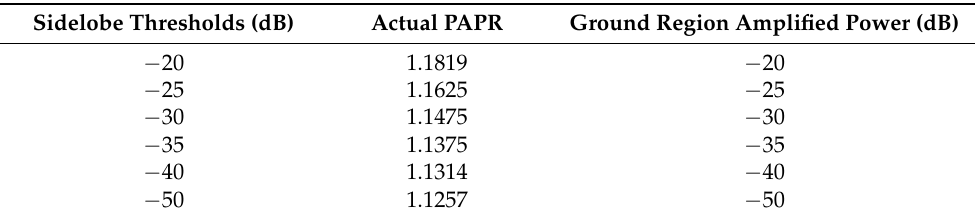
Figure 4. Beam patterns with different η . Table 3. Region amplified power improvement and PAPR under different sidelobe thresholds.